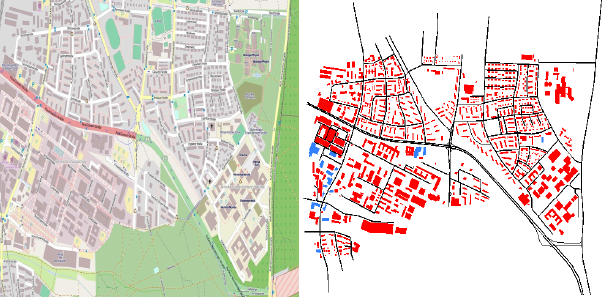
Figure 6. Map clipping from Erlangen, Germany. The figure on the left was imported from OSM and on the right represents the road topology used in our simulations.